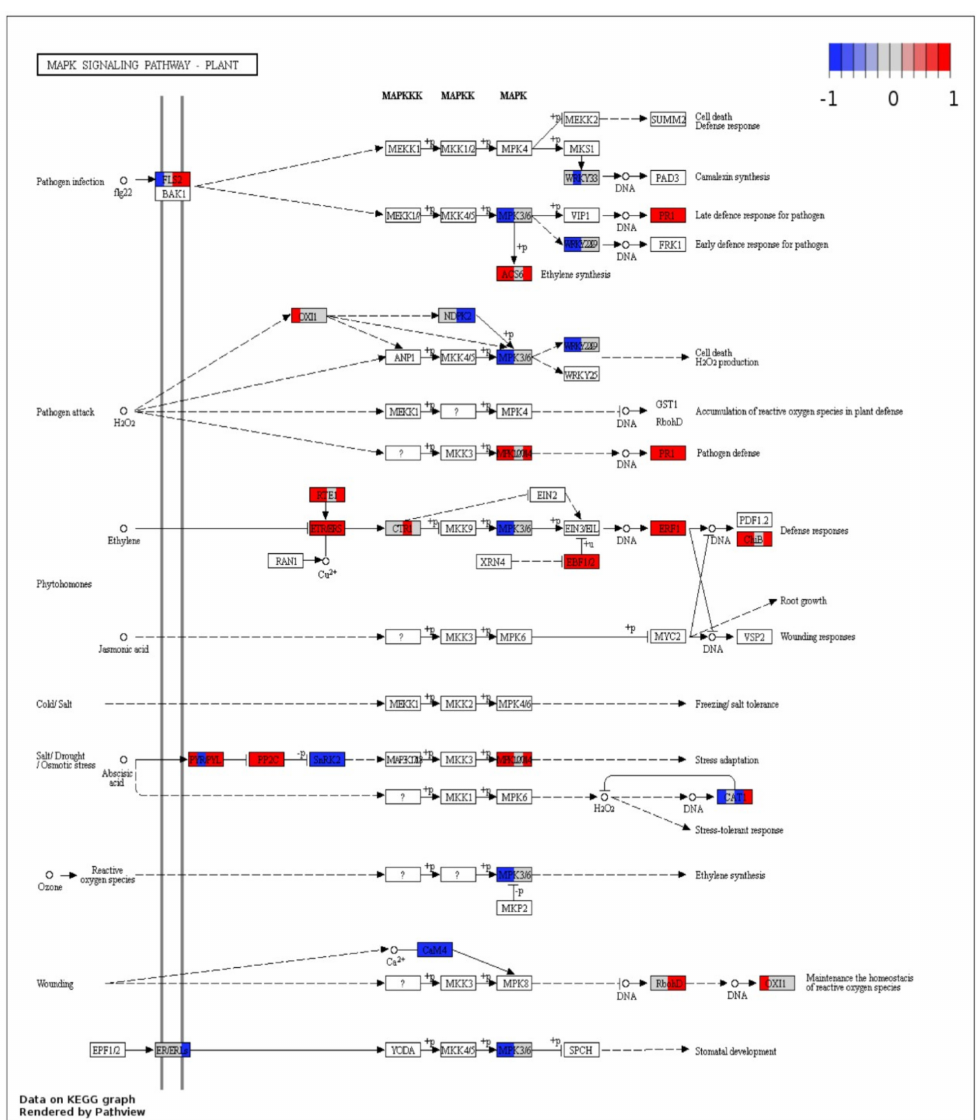
Figure 8. Visualization of DEGs involved in the mitogen activated protein kinase (MAPK) signaling pathway. Each box depicts DEGs from four treatments vs. control comparisons thus divided into four segments, the left half represents Sp-R treatment vs. control with first segment (left) 24 hpi and second 48 hpi. The right half is depicts Sp-S treatment vs. control with first segment (left) 24 hpi and second (right) 48 hpi. White box or no color fill means no DEG was assigned to that KO term. Color gradient represents log2 fold ratios with red representing upregulation and blue representing downregulation in treatments vs. mock samples.